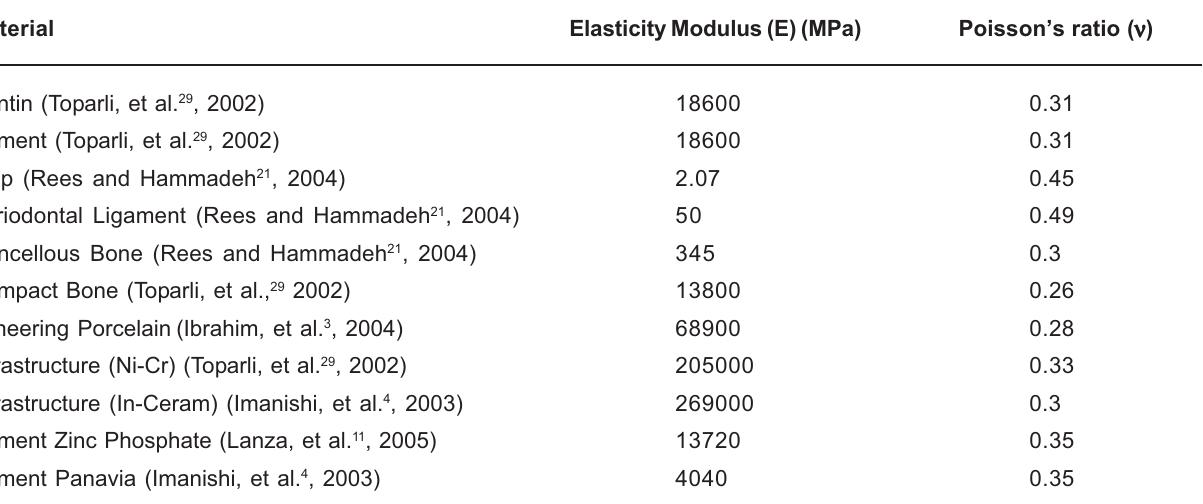
TABLE 1- Mechanical properties of each tooth